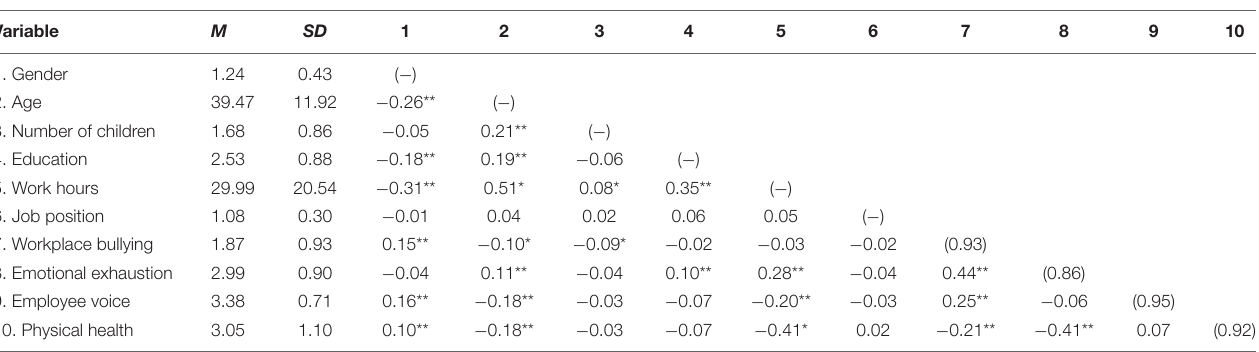
TABLE 2 | Means, standard deviations, Cronbach’s alpha, and intercorrelations among the study.